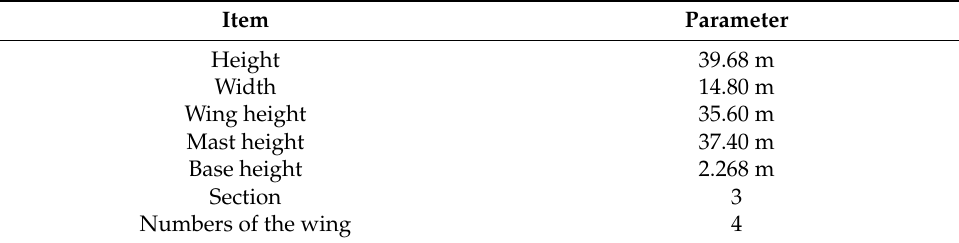
Figure 8. The wing of “NEW ADEN”. Table 1. Main parameters of the